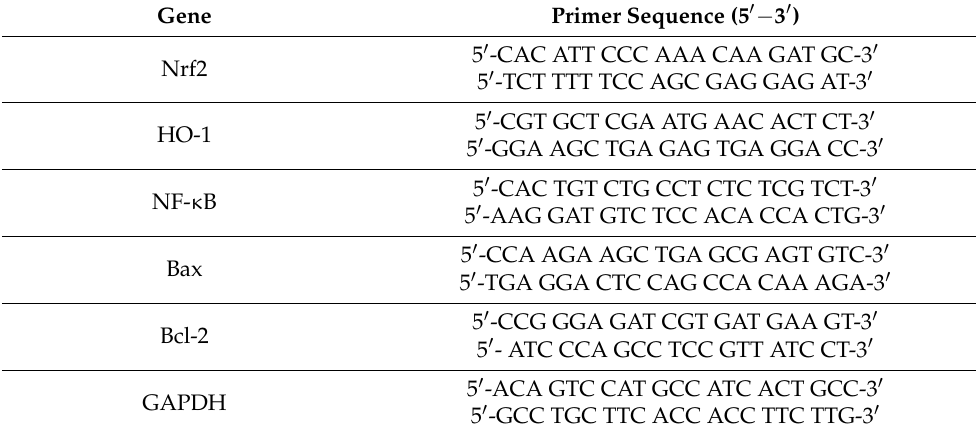
Table 3. The sequences of the primers (5 (cid:48) − 3 (cid:48) ) used for qRT-PCR.